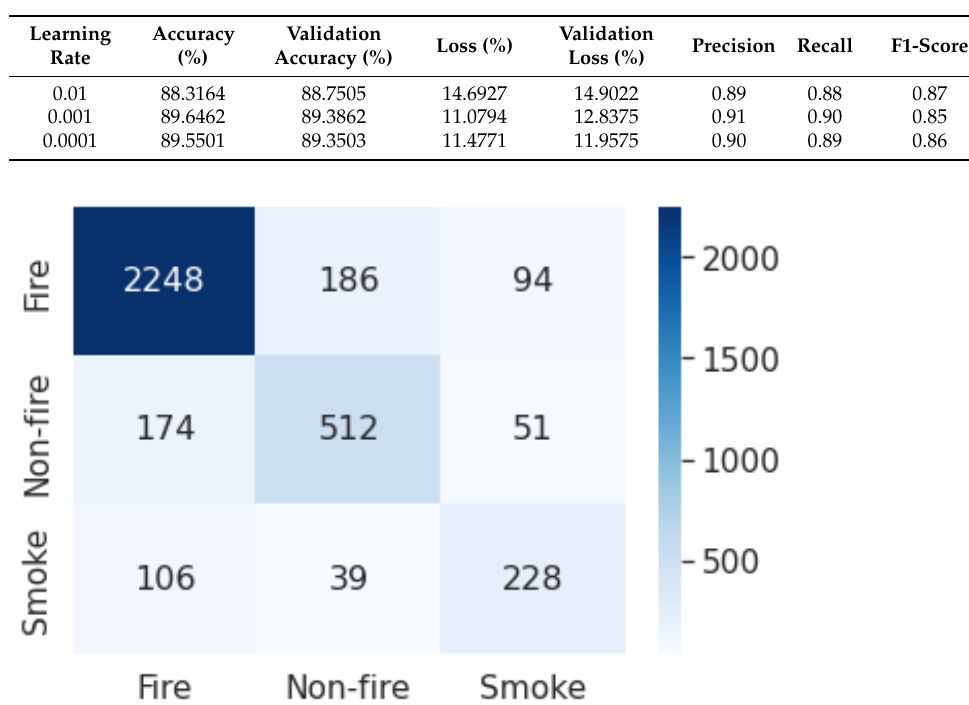
Table 4. Comparison with different learning rates of Adam optimizer and Softmax activation layer.